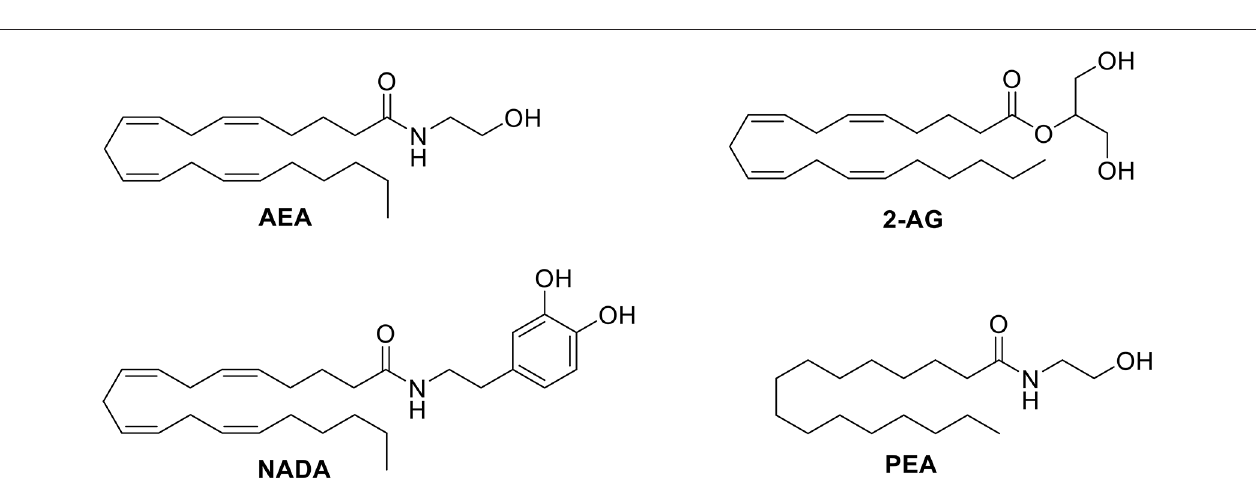
FIGURE 3 | (A) The lipid view of TRPA1 adapted from PDB: 3J9P. ARD shown in red, transmembrane region (TMR) shown in yellow, TRP-like domain shown in purple, ICRs- and ECRs shown in green and coiled-coil shown in pink. Sections have been omitted for clarity. (B) The intracellular view of TRPA1 adapted from PDB: 3J9P. Coiled-coil shown in pink. Sections have been omitted for clarity.